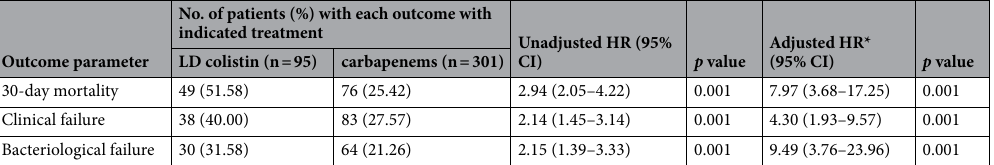
Table 2. Cox regression analysis of outcomes of patients treated with LD colistin and carbapenems for the infection caused by ESBL-producing E. coli and K. pneumoniae. * Adjusted for gender, ICU admission, use mechanical ventilation, duration of hospitalization, appropriate antibiotic treatment, Charlson comorbidity score, cerebrovascular disease, diabetes mellitus, infection type and nephrotoxicity. CI, confidence interval; HR hazard ratio.